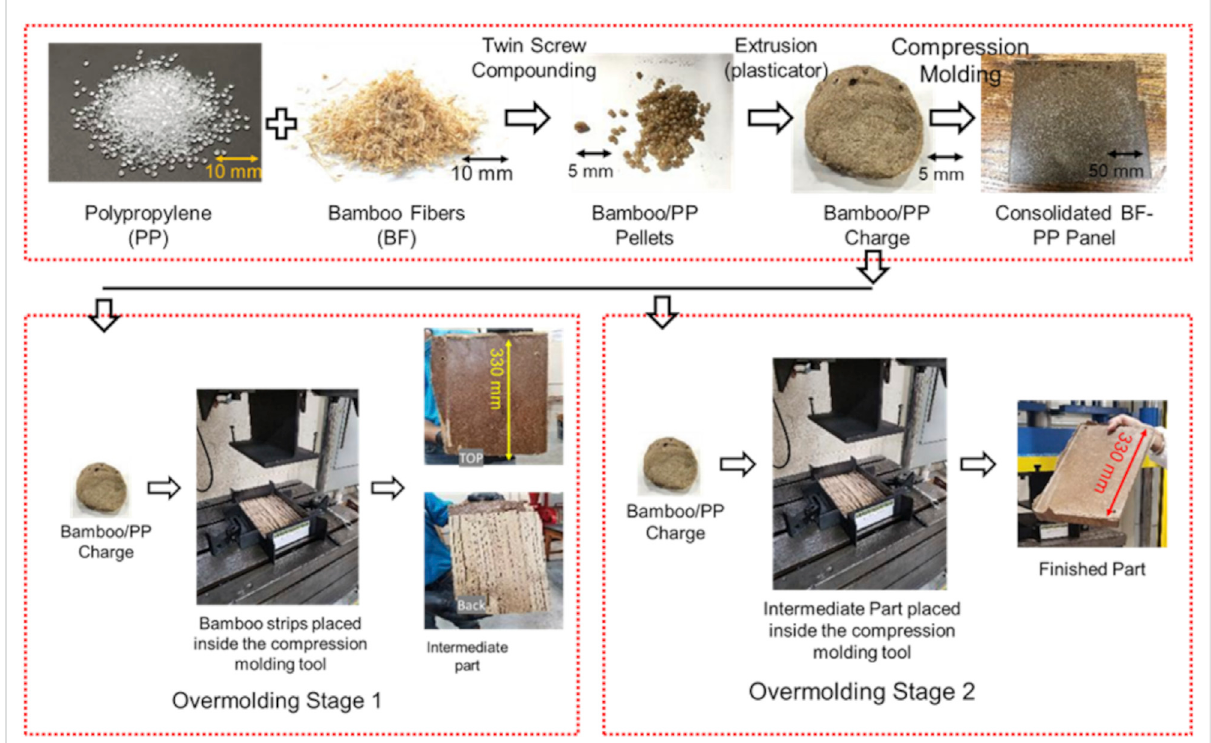
FIGURE 2 Process fl ow for extrusion compression molding of PP-BF composites and ECM of PP-BF-BS composite for trailer decking.